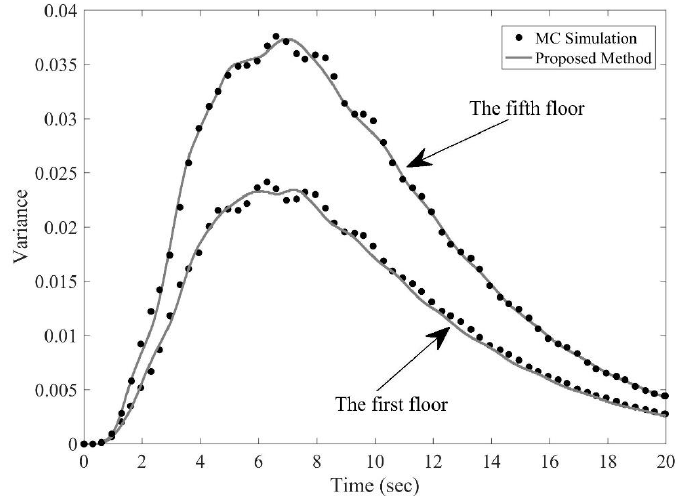
Figure 15. Mean square displacement response of a 5DOF Duffing – Van der Pol system under nonstationary excitation. ( γ = 1.0, µ = 10.0).